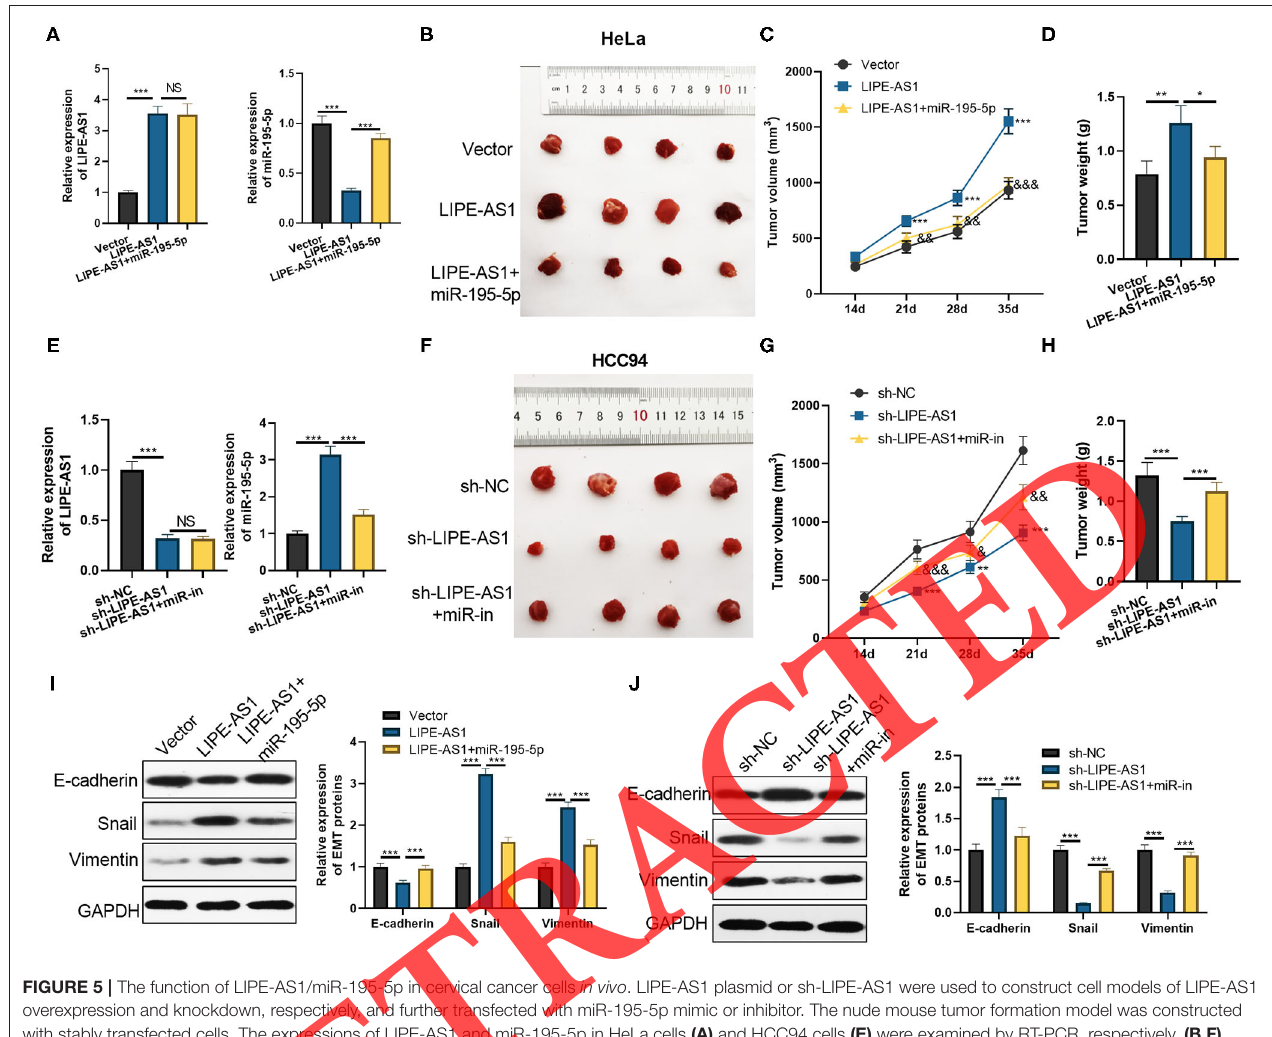
FIGURE 5 | The function of LIPE-AS1/miR-195-5p in cervical cancer cells in vivo . LIPE-AS1 plasmid or sh-LIPE-AS1 were used to construct cell models of LIPE-AS1 overexpression and knockdown, respectively, and further transfected with miR-195-5p mimic or inhibitor. The nude mouse tumor formation model was constructed with stably transfected cells. The expressions of LIPE-AS1 and miR-195-5p in HeLa cells (A) and HCC94 cells (E) were examined by RT-PCR, respectively. (B,F) Nude mice were sacrificed in the fifth week, and tumor tissue was removed. (C,G) Tumor volume in nude mice; (D,H) tumor mass at the fifth week; (I,J) western blot was taken to determine the expressions of E-cadherin, Snail, and Vimentin in tumor tissues. NS P > 0.05, * P < 0.05, ** P < 0.01, *** P < 0.001. & P < 0.05, && P < 0.01, &&& P < 0.001 vs. LIPE-AS1 group or sh-LIPE-AS1 group. N = 4.